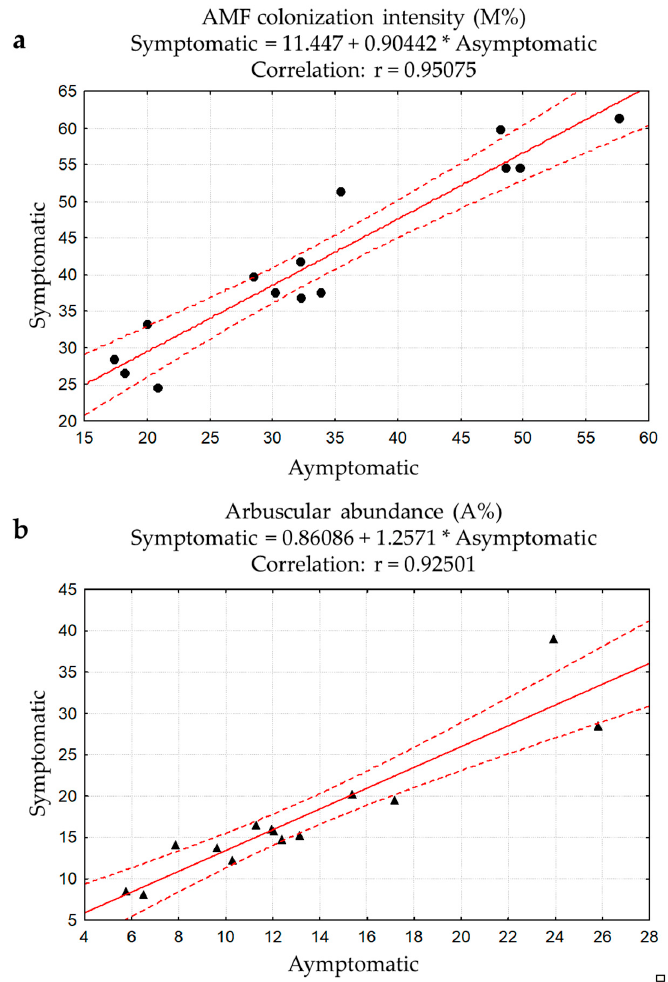
Figure 2. Correlation related to AMF mycelium colonization ( a ) and arbuscular abundance ( b ) detected by non-vital staining in asymptomatic and nearby esca symptomatic plants. Pearson’s coefficient (r) p < 0.05.